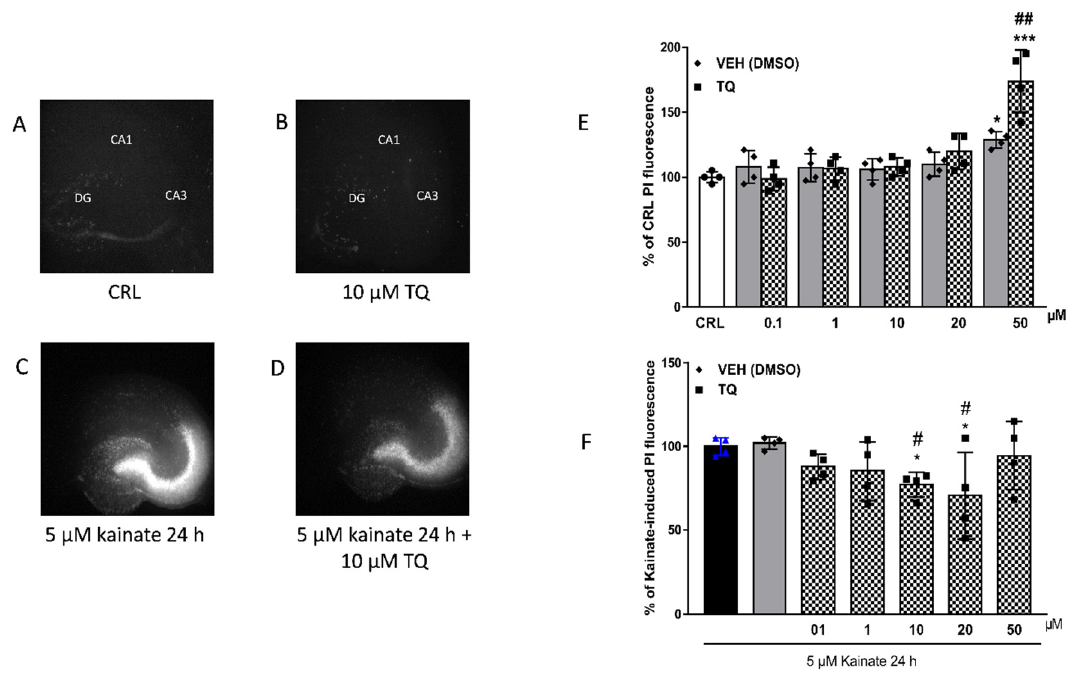
Figure 2. Effects of TQ in organotypic hippocampal slice cultures exposed to KA. ( A ) representative hippocampal slice under normal conditions (background PI fluorescence); representative slice incubated with 10 µ M of TQ in basal condition ( B) ; representative slice exposed to 5 µ M kainate 24 h displaying intense PI labelling in the CA3 subregion ( C ); TQ effect on KA-induced PI labelling ( D ). ( E ): Quantitative analysis of PI fluorescence measured after 24 h of incubation with TQ (0.1–50 µ M) and its corresponding vehicle in basal condition. * p < 0.05, *** p < 0.001 vs. CRL and ## vs. corresponding vehicle (ANOVA + Tukey’s w -Test). ( F ) Quantitative analysis of PI fluorescence measured after 24 h of incubation with TQ (0.1-50 µ M) and its corresponding vehicle in the Kainate-induced injury model. Bars represent the mean ± SEM of at least four experiments run in quadruplicate, from independent slice preparations (about 16 slices for each experimental point). * p < 0.05 vs. KA; # p < 0.05 vs. VEH (ANOVA + Tukey’s w -Test).